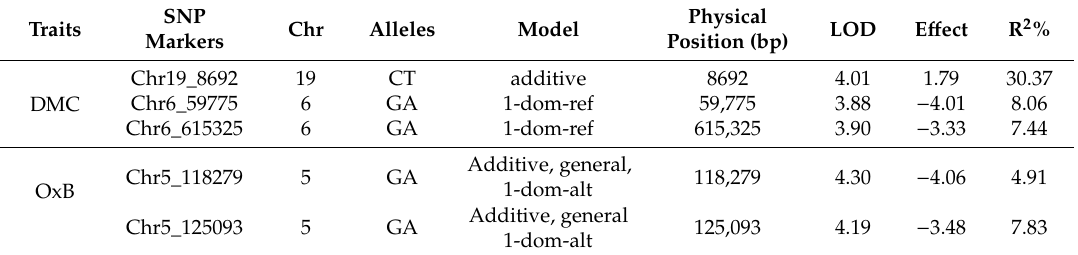
Table 3. Summary of significant single nucleotide polymorphism (SNPs) describing di ff erent genomic regions associated with tuber DMC and OxB in a panel of 100 D. alata